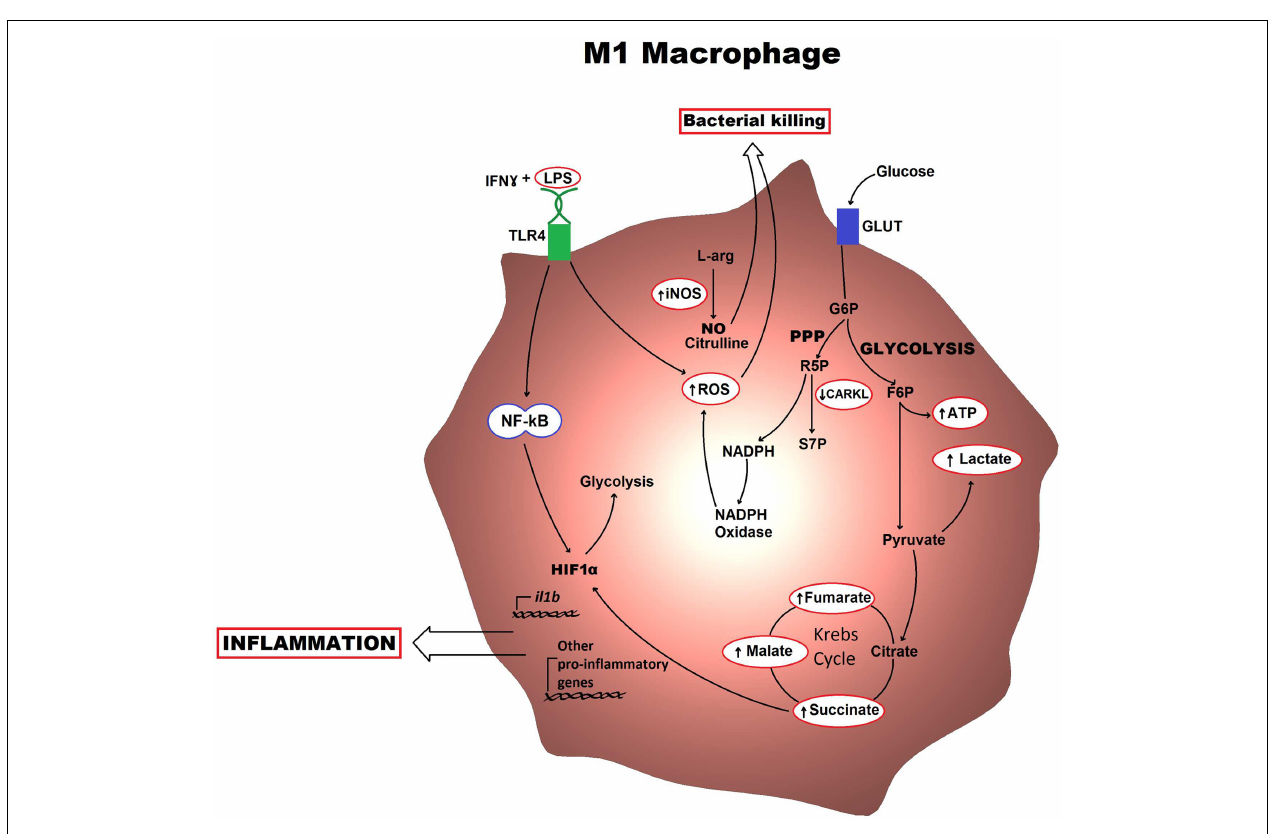
functional consequences are bacterial killing, mostly through the production of ROS and NO, and inflammation, which occurs via cytokine production. G6P, glucose-6-phosphate; F6P, fructose-6-phosphate; R5P, ribulose-5-phosphate; S7P, sedoheptulose phosphate; NO, nitric oxide; ROS, reactive-oxygen